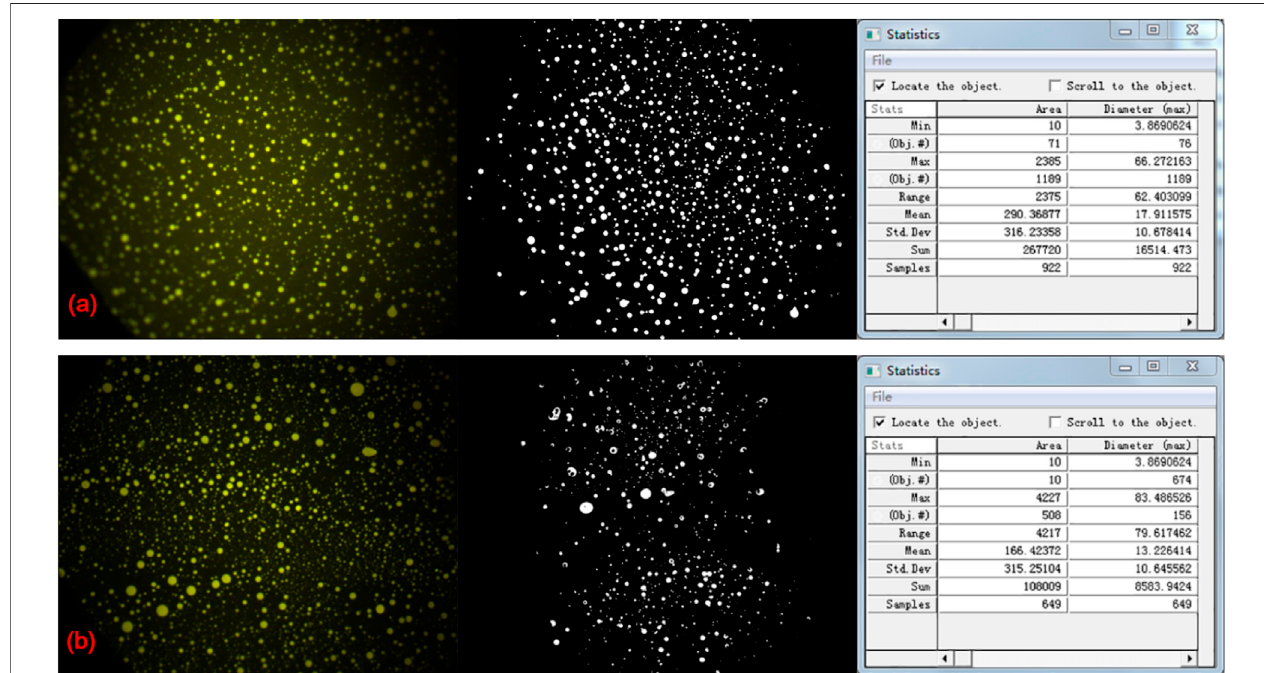
FIGURE 5 | Binarization treatment results of (A) specimen 5 ’ and (B) specimen 6 ’ .